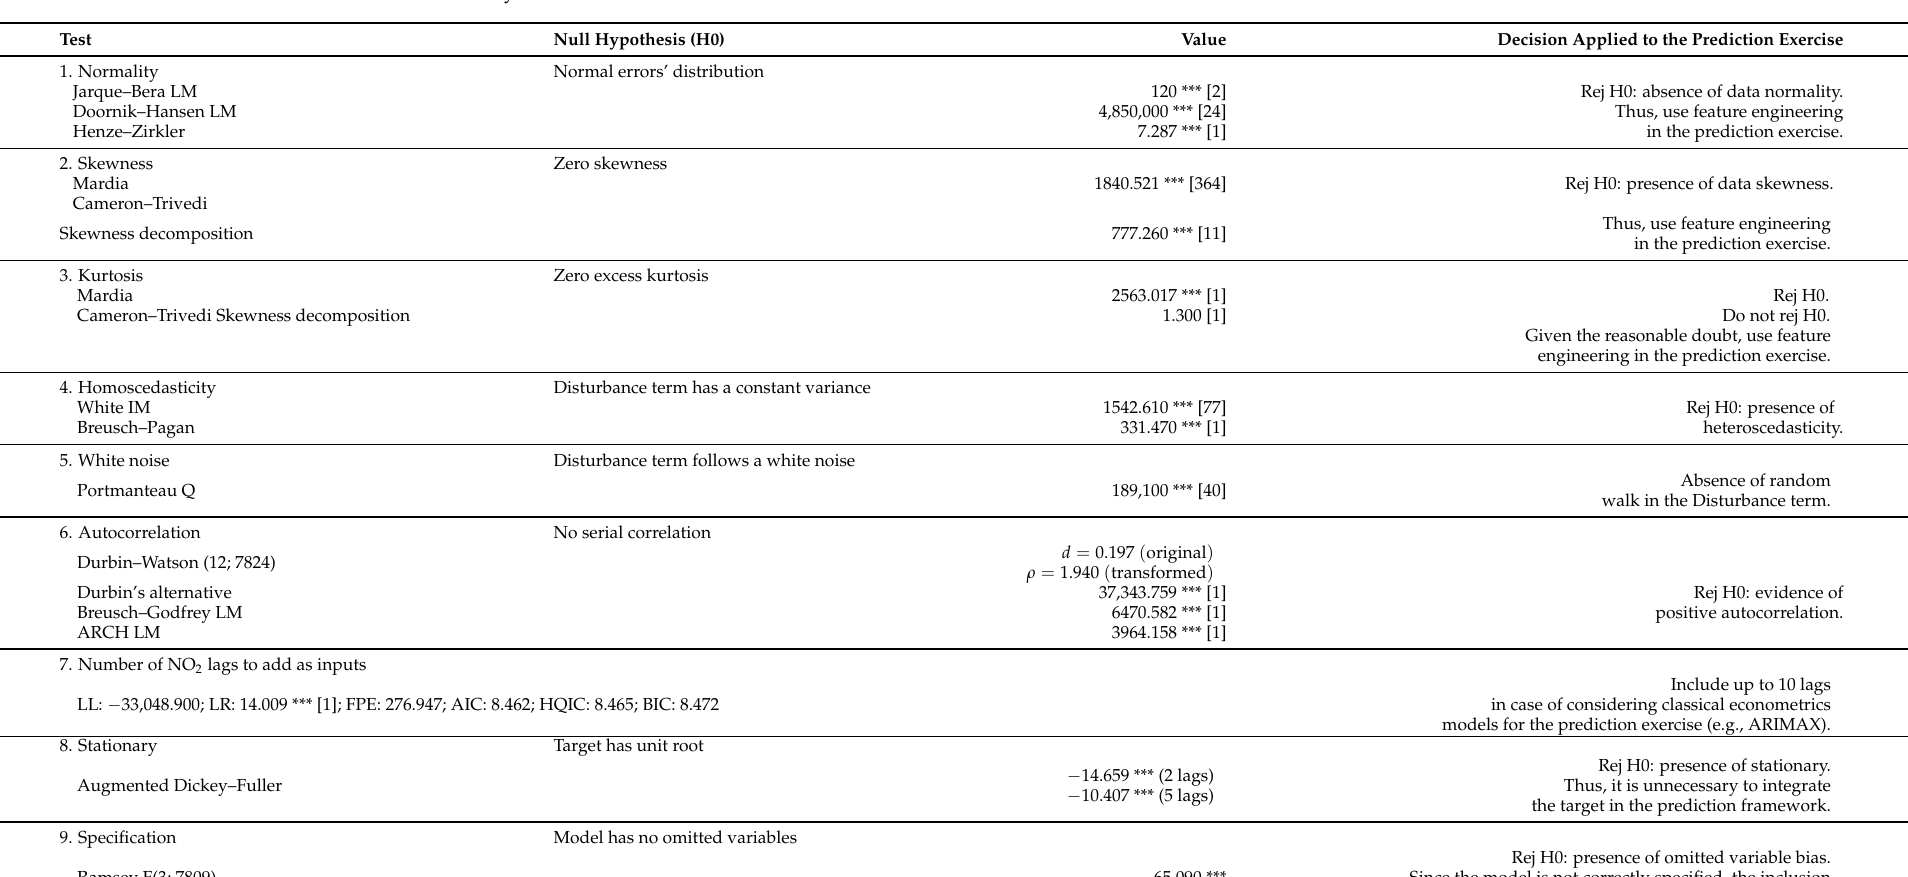
Table 3. Preliminary statistical